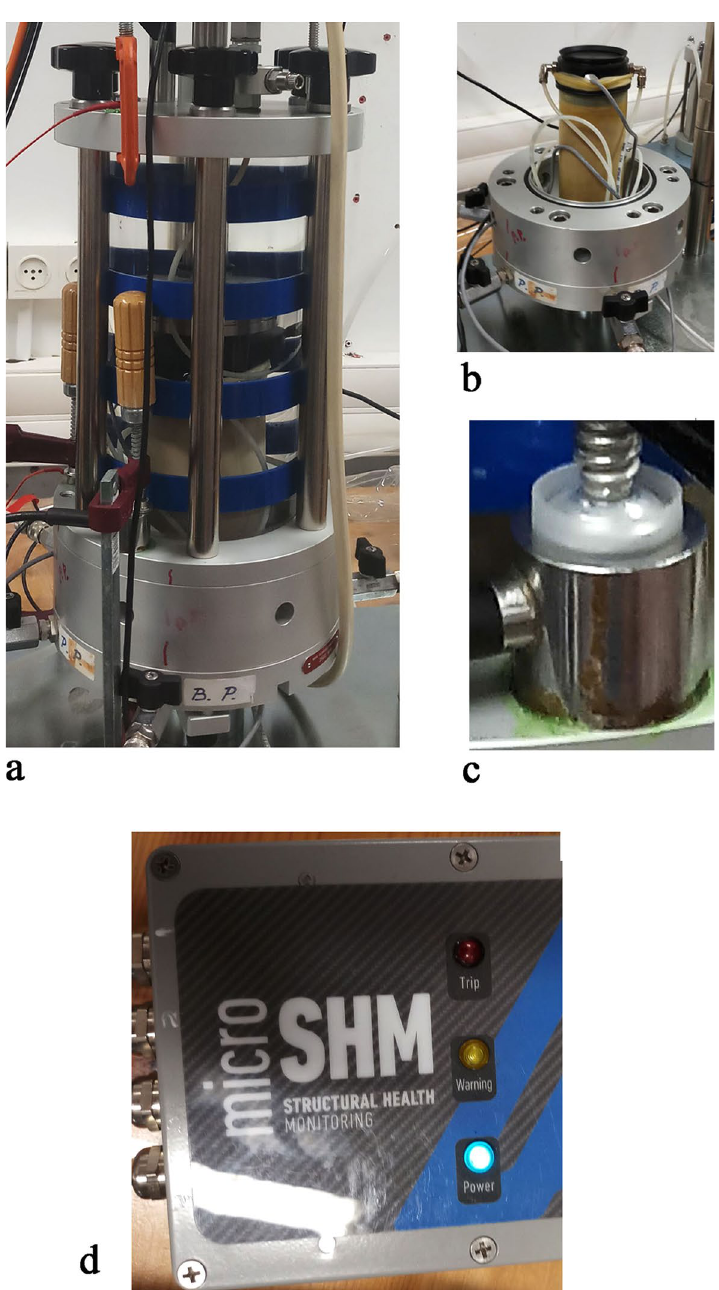
Figure 2. The research instruments: ( a ) the dynamic loading system (Controls SpA., Italy), ( b ) the sand sample: diameter and length are 70 and about 120 mm, respectively, ( c ) the AE sensor. ( d ) The “micro SHM monitoring system” (Mistras/Physical Acoustic